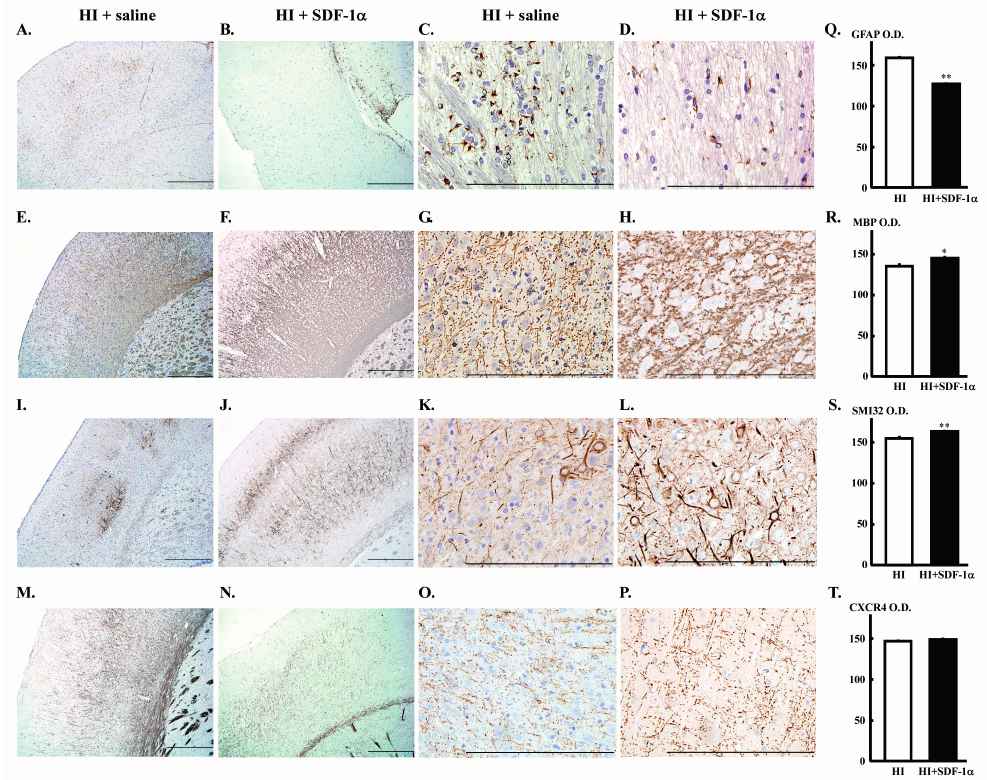
Figure 5. Immunohistochemistry of neonatal rat brains after HI. ( A – D , Q ) Representative cerebrum sections stained with anti-GFAP. Increased GFAP expression in WM was decreased by treatment with 600 µg/kg SDF-1 α . Quantification data for each marker are presented. ** p < 0.01 vs. HI group; ( E – H , R ) Representative cerebrum sections stained with anti-MBP. Weak MBP immunostaining in WM of the HI group was increased by treatment with 600 µg/kg SDF-1 α . * p < 0.05 vs. HI group; ( I – L , S ) Representative cerebrum sections stained with anti-SMI 32. Weak SMI 32 immunostaining in WM increased by treatment with 600 µg/kg SDF-1 α . ** p < 0.01 vs. HI group; ( M – P , T ) Representative cerebrum sections stained with anti-CXCR4. Extensive CXCR4 immunostaining in WM was not changed by treatment with 600 µg/kg SDF-1 α . Bar is 500